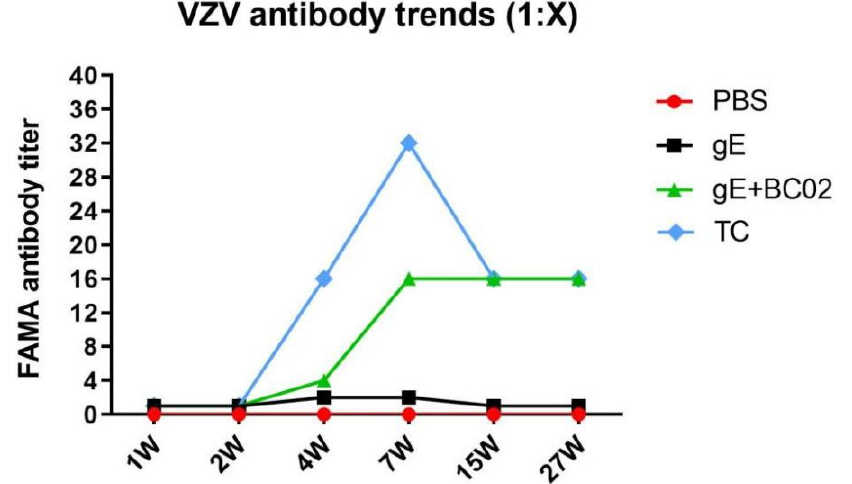
Figure 5. Trend analysis of anti-VZV antibodies induced by BC02-adjuvanted gE experimental vaccine. FAMA serology test to determine susceptibility to VZV infection. An antibody titer cut-off value of ≥ 1:4 represents seropositivity, indicating potential protection against VZV infection (Sera from 6 mice were pooled). TC is the abbreviation of test control. Table 1. Fluorescence signal intensity of mouse serum FAMA assay at different time points and different dilution ratios after immunization .